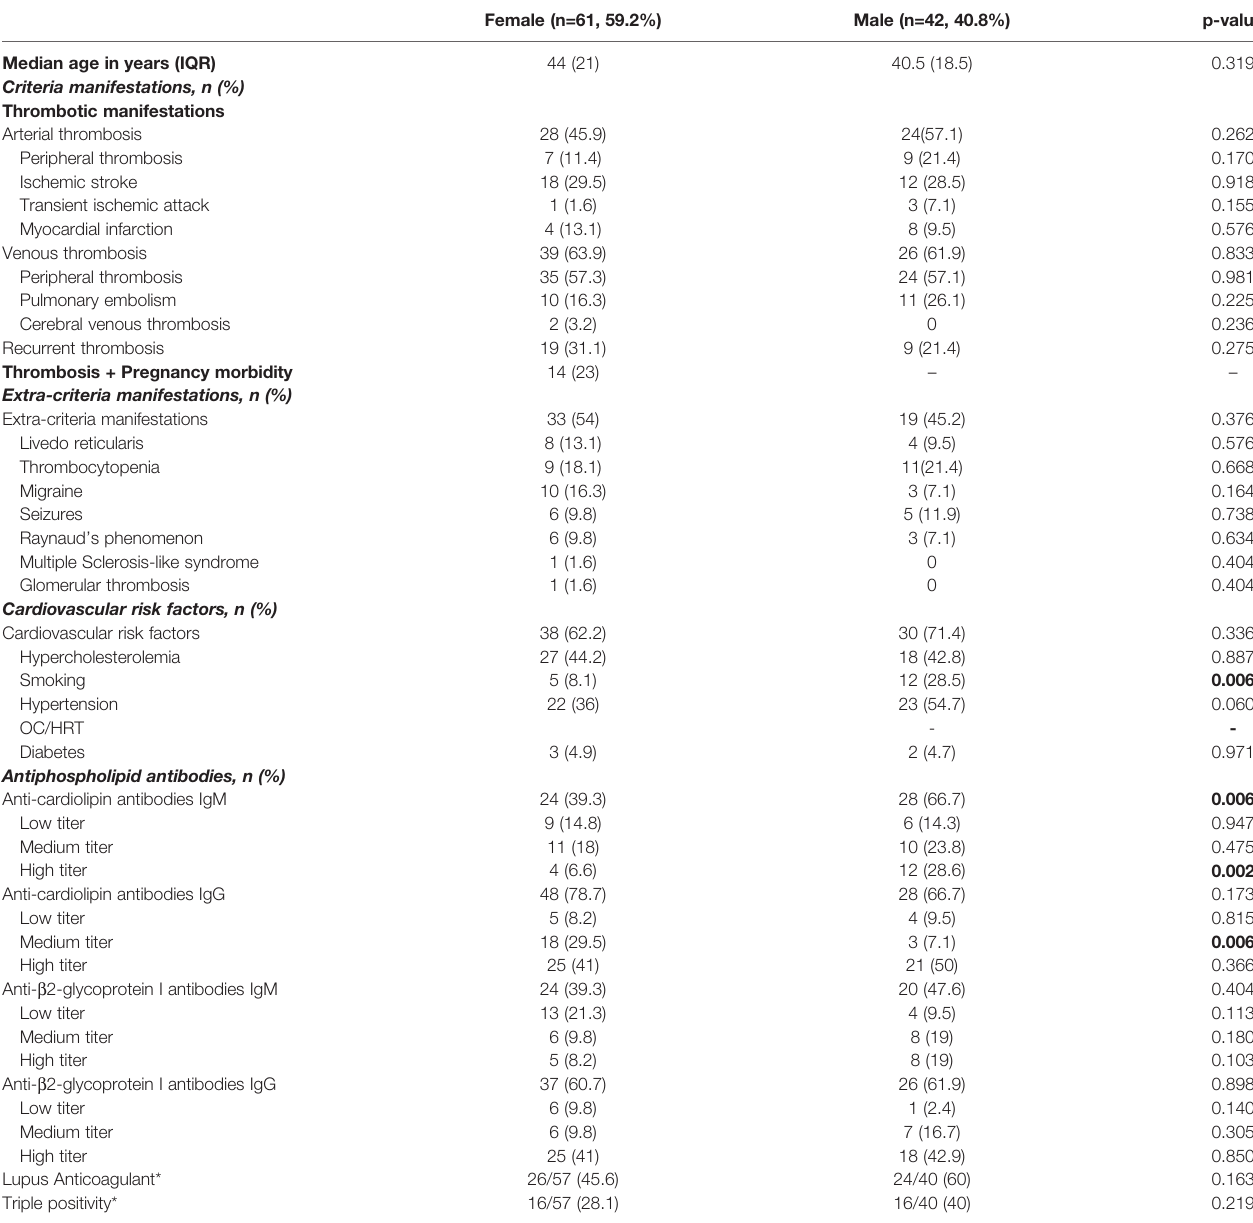
TABLE 3 | Clinical and laboratory characteristics of PAPS patients with thrombotic